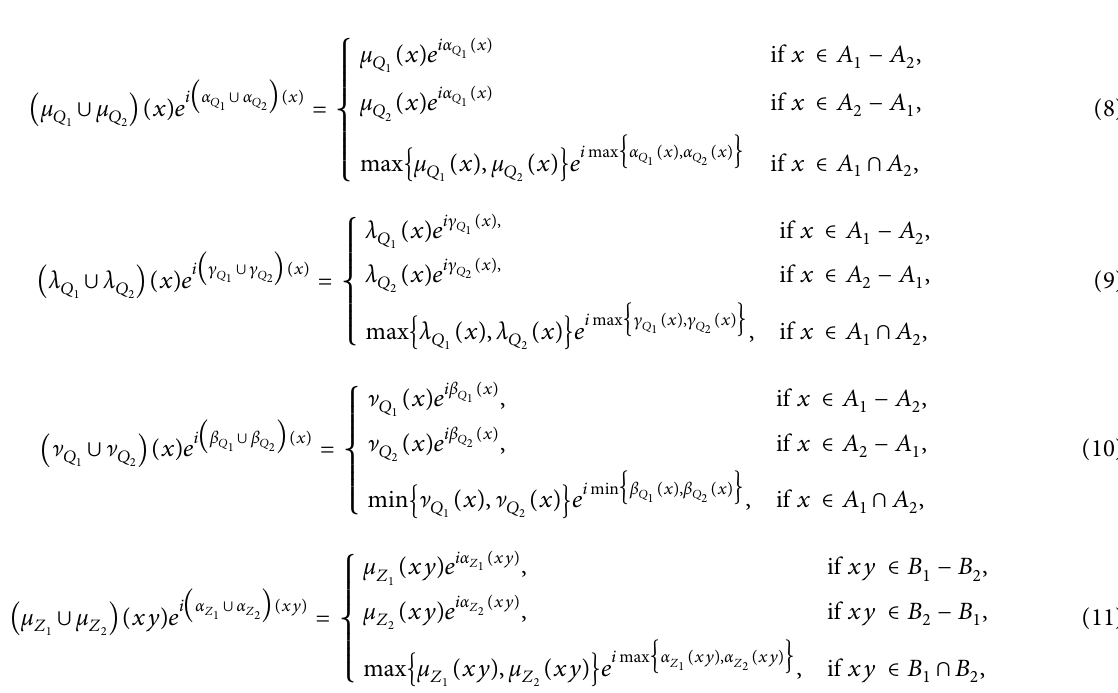
Figure 4: Complement of